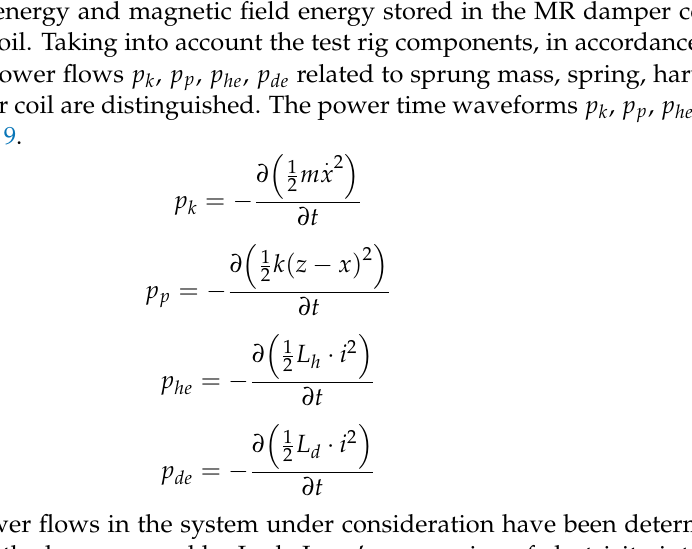
mitted by the shaker can be both supplied to and received from the system. The result of the changes is determined by power flow p s Equation (2) and shown by the time